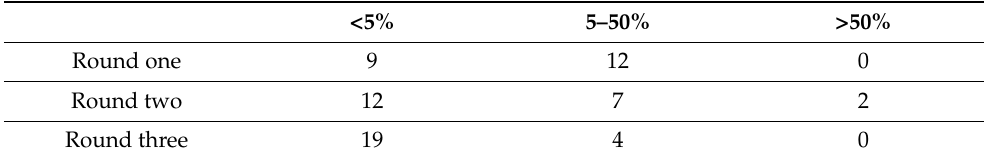
Table 1. Number of countries in the study region reporting disruptions within the specified magni- tude brackets.